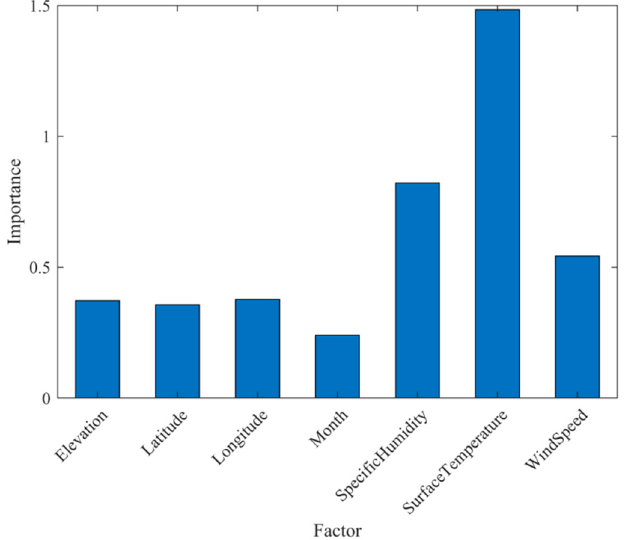
Figure 10. Importance ranking of seven factors (without albedo): IST, specific humidity, wind speed, month, elevation, latitude, and longitude.